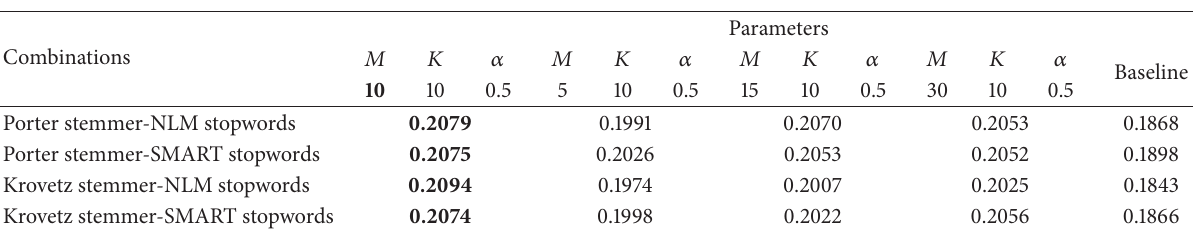
Table 8: Finding the best values of the parameters for TF-IDF BM25 feedback.